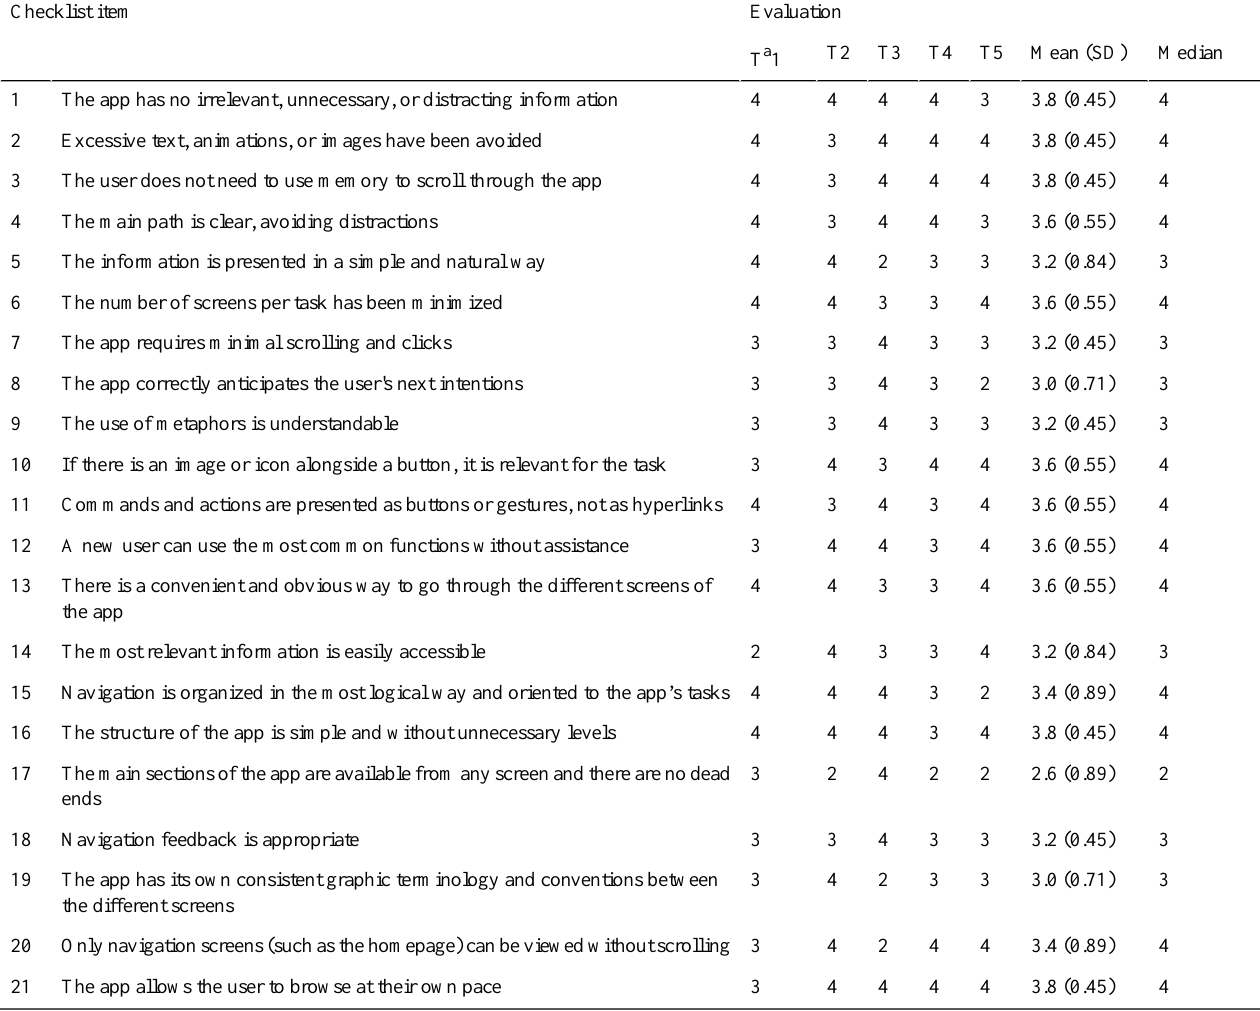
Table 2. Navigation and tasks checklist and respective peer review test results. EvaluationChecklist